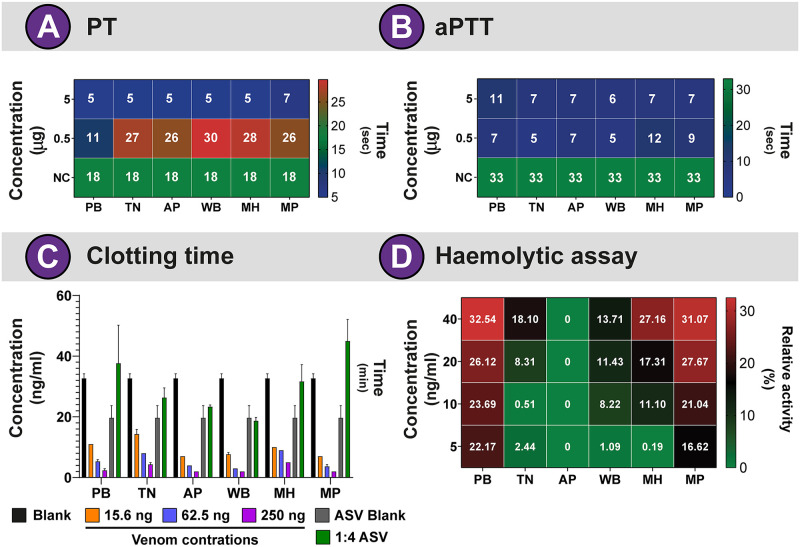
Coagulopathies induced by the biogeographically distinct populations of D. russelii.Heatmaps depict the influence of D. russelii venoms in impeding the (A) extrinsic and (B) intrinsic blood coagulation pathways, respectively. (C) The impact of varying concentrations of venoms (15.6 to 250 ng) on plasma clotting time (mins), and the ability of Premium Serums antivenom (1:4 dilution of 1 mg/ml or 0.25 μg/μl antivenom) in neutralising these effects are shown as bar graphs. The error bars represent the standard deviation among the replicates. (D) Haemolytic activities of D. russelii venoms have also been shown. Numbers inside each tile in A and B denote the plasma clotting time in seconds, and the numbers in D indicate the percentage of relative activity with respect to the positive control (0.5% Triton X). Blank: plasma control; ASV Blank: plasma + antivenom (1:4); NC: negative control; PB: Punjab; TN: Tamil Nadu; AP: Andhra Pradesh; WB: West Bengal; MH: Maharashtra; MP: Madhya Pradesh.